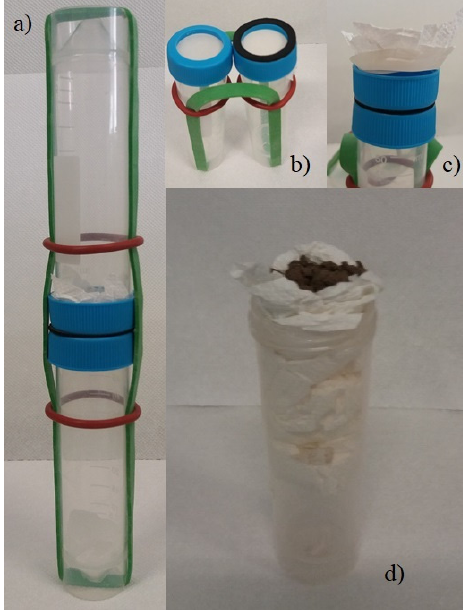
Figure 3. Degradation analysis systems: ( a ) complete system; ( b ) opened system showing the cell in which the hydrogel is inserted; ( c ) disposition of the synthetic fabric and piece of absorbent paper in the upper Falcon tube; ( d ) lower Falcon tube of the degradation analysis system with 4 g of soil and absorbent paper.